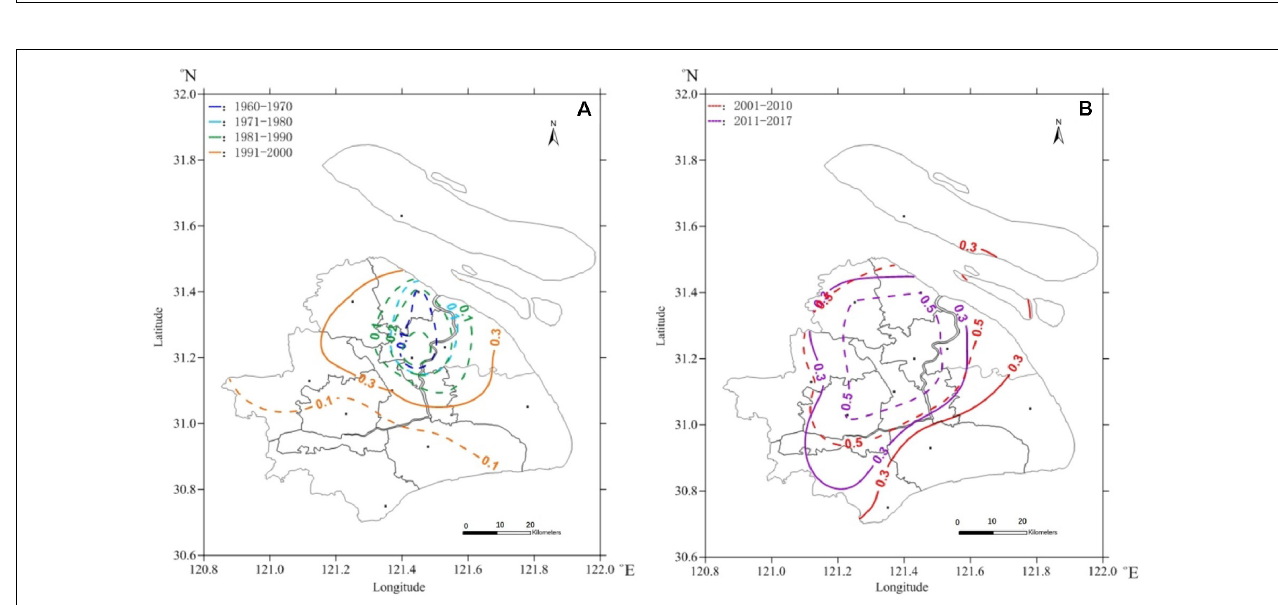
FIGURE 6 | The distribution of different levels of heat islands intensity (unit: ◦ C) from the 1960s to 1990s (A) and from 2000s to the present (B) .